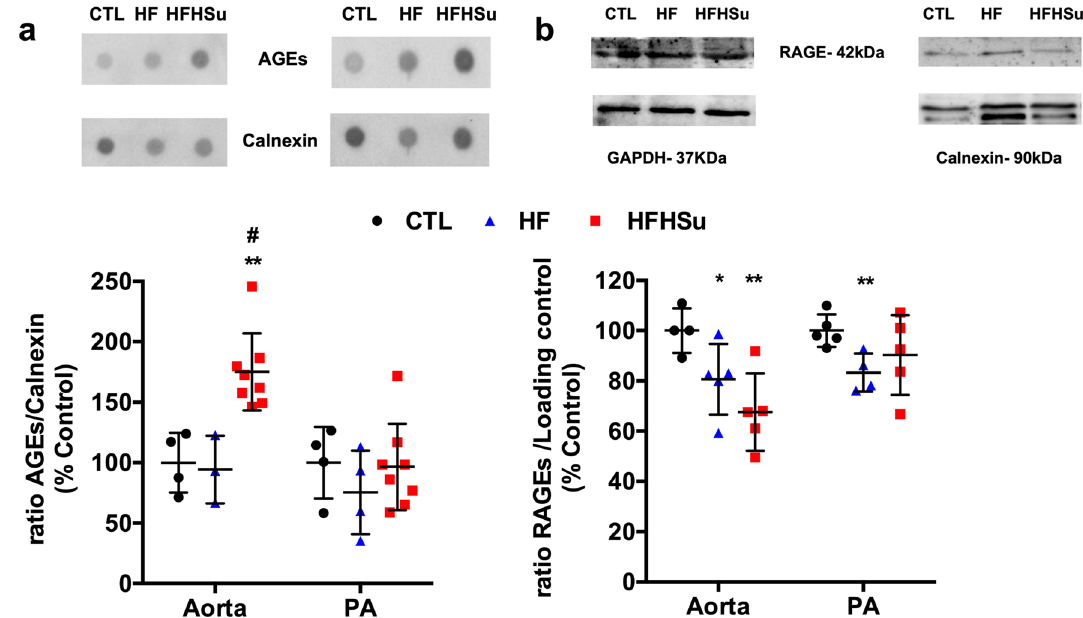
Figure 5. Effect of type 2 diabetes progression on AGEs levels and AGEs receptor expression. ( a ) Average relative levels of AGEs, and the loading protein Calnexin, on aorta and PA of control animals (n = 3–4) and animals submitted to HF (n = 3–4) or HFHSu (n = 6–8) diets. ( b ) Average relative expression of RAGE (42 kDa) and the loading protein used—Calnexin (90 kDa) or GAPDH (37 kDa)—in aorta and PA of control animals (n = 4–5) and animals submitted to HF (n = 4–5) and HFHSu (n = 4–5) diets. Representative western blots for each protein studied are depicted above the respective graphs. For complete membrane image see Supplementary data. Values are presented as scatter plots ± SD; One-way ANOVA with Dunnet’s comparison test. * p < 0.05 and ** p < 0.01 versus control animals; # p < 0.05 comparing the groups submitted to the hypercaloric